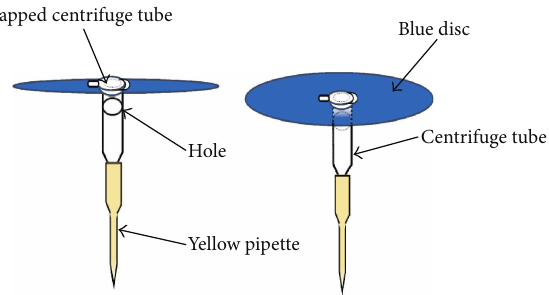
Figure 2: Artificial flowers were made of 1.5mL centrifuge tubes inserted into the centres of blue plastic discs, 7 cm in diameter. The centrifuge tube was capped so that the bees could not obtain the contained syrup from the surface of the plastic disc. Instead, a small hole (0.5 cm in diameters) had been drilled into one side of each centrifuge tube just below the